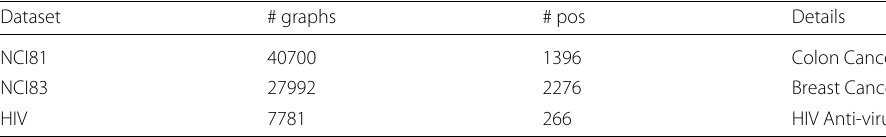
Table 1 Summary of experimental datasets